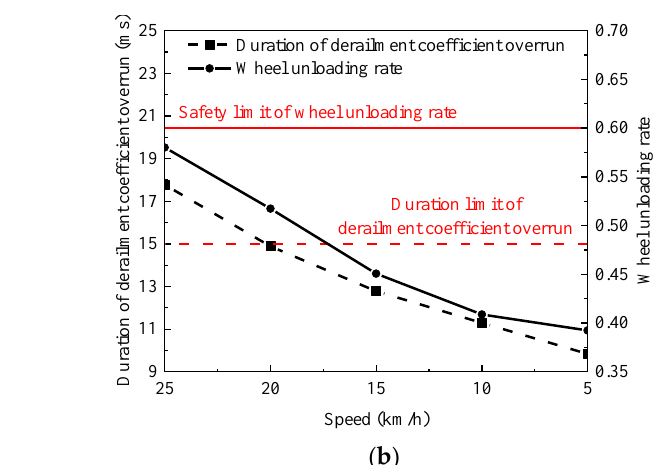
Figure 16. Wheel-rail lateral force and axle lateral force in the time domain.